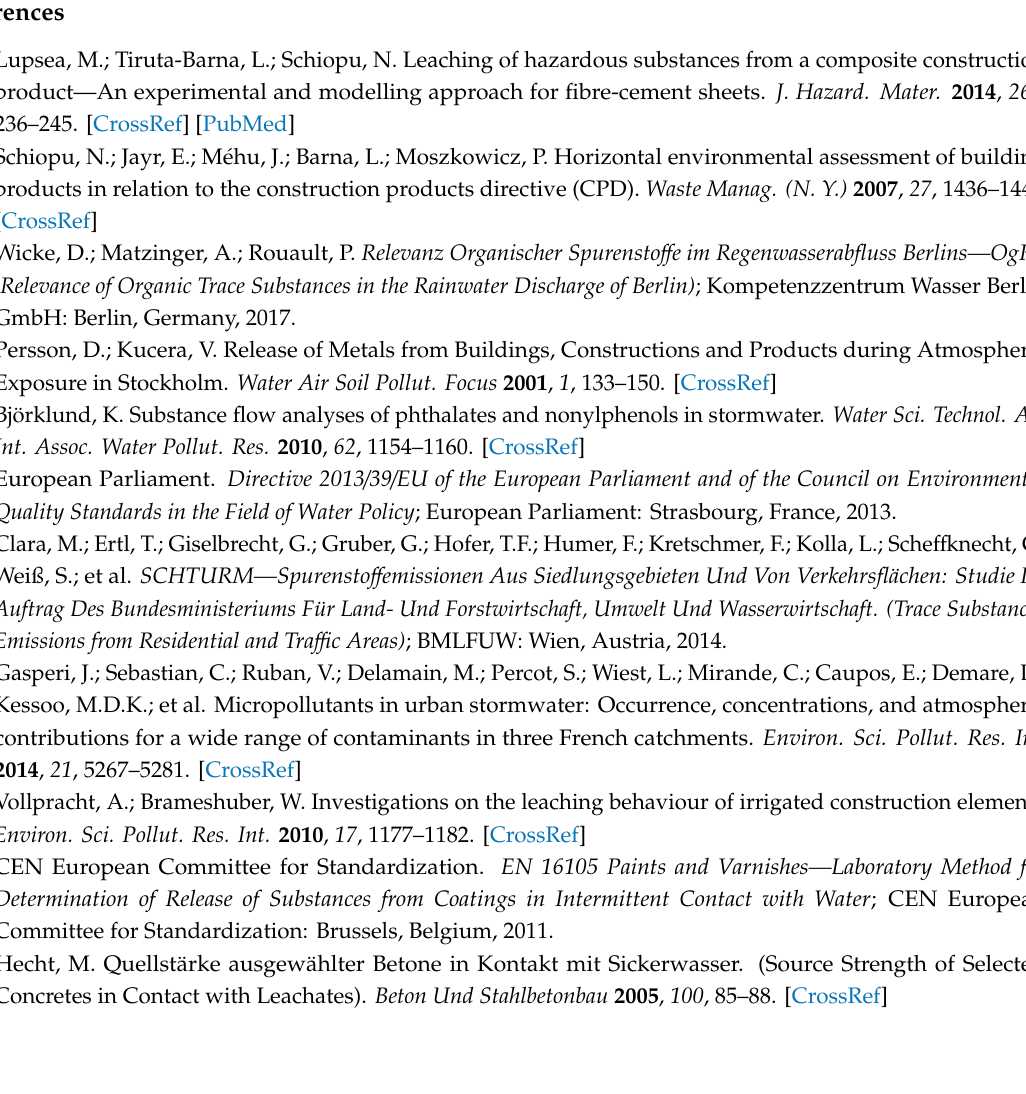
F 1g B: heavy metal and trace element concentrations, part 2, Table S43: Outdoor irrigation results of the test specimen F 4g A: leachate amount, pH value, electrical conductivity, and concentrations of sodium, potassium, calcium, chloride, and sulfate, Table S44: Outdoor irrigation results of the test specimen F 4g A: heavy metal and trace element concentrations, part 1, Table S45: Outdoor irrigation results of the test specimen F 4g A: heavy metal and trace element concentrations, part 2, Table S46: Outdoor irrigation results of the test specimen F 4g B: leachate amount, pH value, electrical conductivity, and concentrations of sodium, potassium, calcium, chloride, and sulfate, Table S47: Outdoor irrigation results of the test specimen F 4g B: heavy metal and trace element concentrations, part 1, Table S48: Outdoor irrigation results of the test specimen F 4g B: heavy metal and trace element concentrations, part